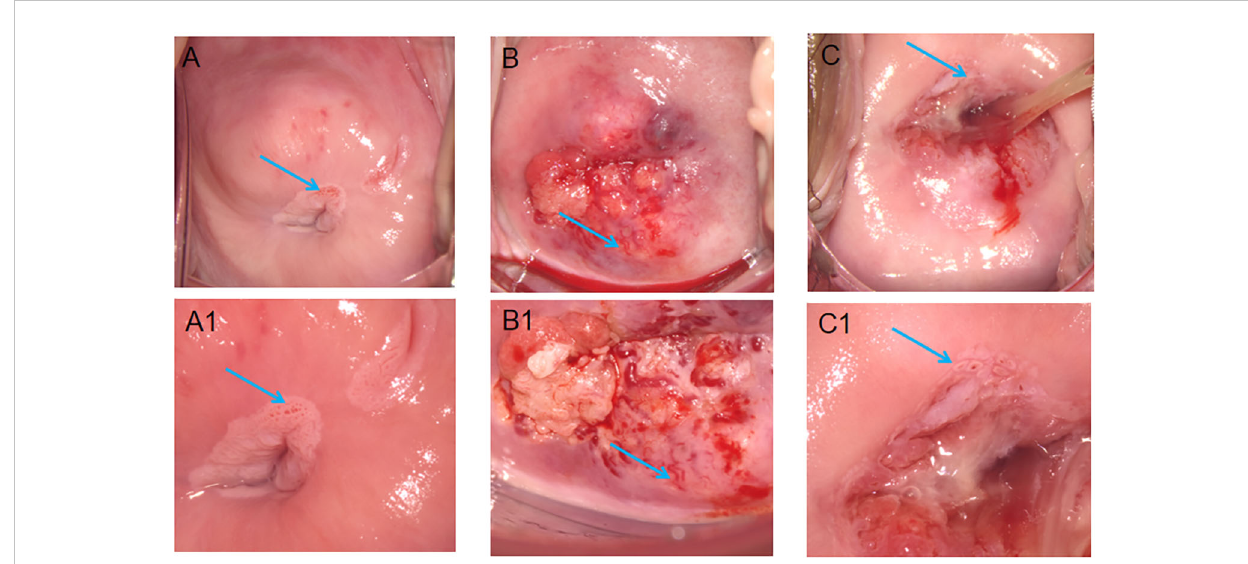
FIGURE 2 Features of different cervical vessels on colposcopy. (A) The arrows point to the punctate vessels of the cervix; (B) The arrows point to the cervical heteromorphic blood vessel; (C) The arrows point to the cervical vascular mosaic; (A1, B1, C1) is the image after (A – C) is enlarged,